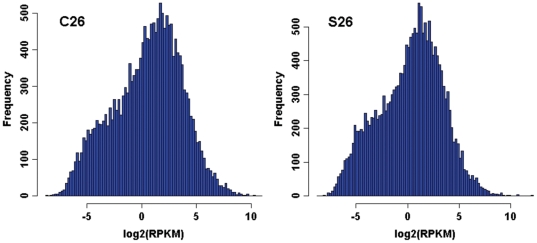
Histogram showing the distribution of gene expression values (in log2RPKM) for all genes in representative samples C26 and S26.The gene expression levels were first normalized to RPKM values and then log2 transformed as shown on x axis. Y axis indicates the number of genes with expression values falling in the particular log2RPKM intervals. This figure shows the similar distributions of gene expression values for all genes between C26 and S26.